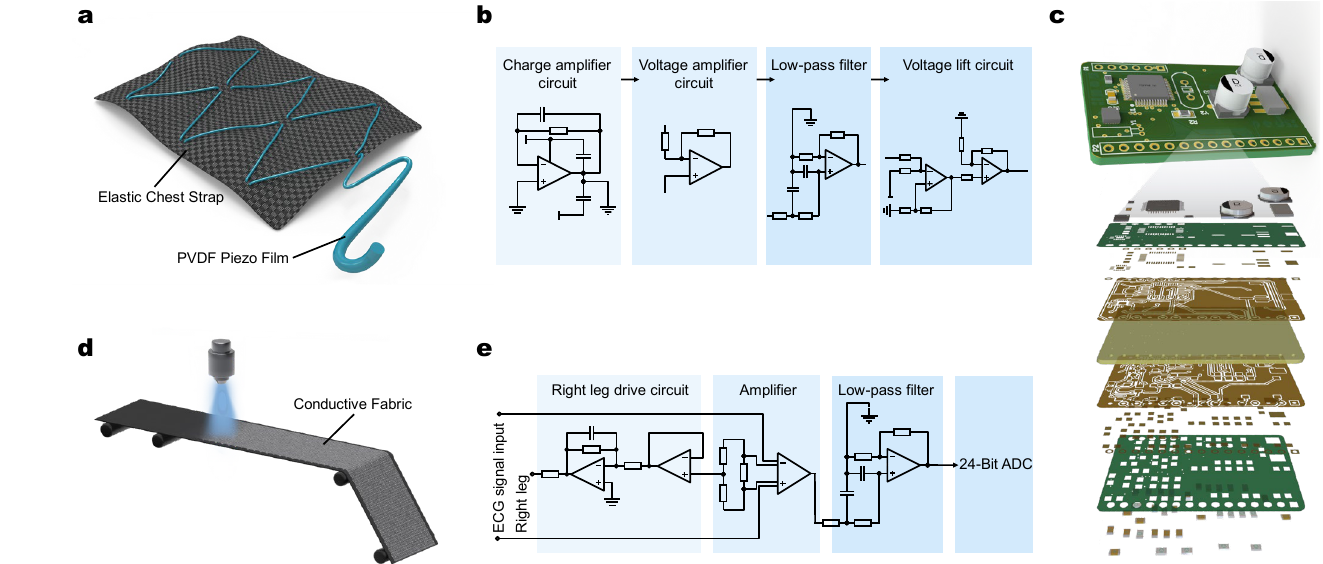
Figure 2. Architecture of the components of airline point-of-care system. ( a ) Fabrication process of breathing coil in elastic chest strap of the wearable terminal, the green line represents PVDF. ( b ) Breathing signal conditioning circuit pattern, including charge amplifier, voltage amplifier, low-pass filter, and voltage lift circuit. ( c ) PCB board displayed in layers. ( d ) Fabrication process of flexible ECG electrodes: from the inner side are the basal layer, the elastic support layer and the conductive fabric, respectively. ( e ) ECG signal conditioning module including right leg drive circuit, amplifier, and low-pass filter, finally 24 Bit ADC.